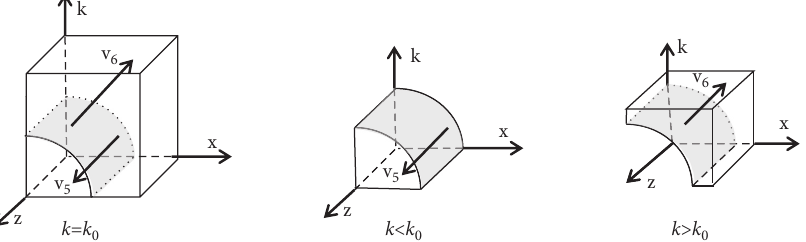
Figure 3: Phase diagram of asset management companies’ strategy selection. (a) k � k